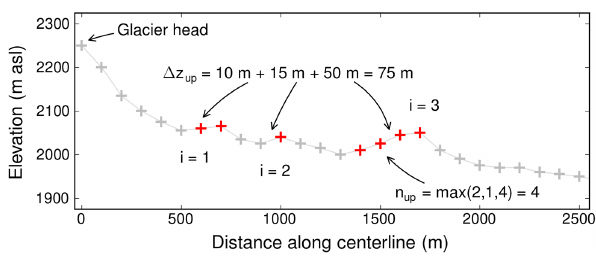
Fig. 5. Elevation profile along a glacier centerline illustrating the definition of 1z up (total elevation increase, Eq. 5) and n up (maxi- mum number of samples with continuous elevation increase, Eq. 6) for I = 3